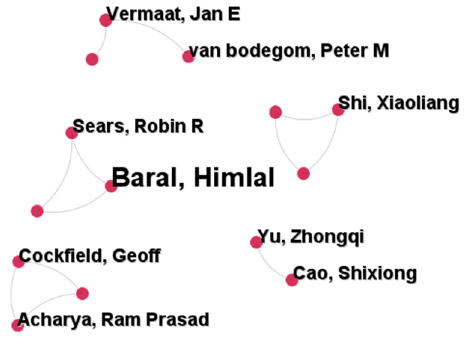
Figure 3. Institutional cooperation in research on forest ecosystem services among countries.